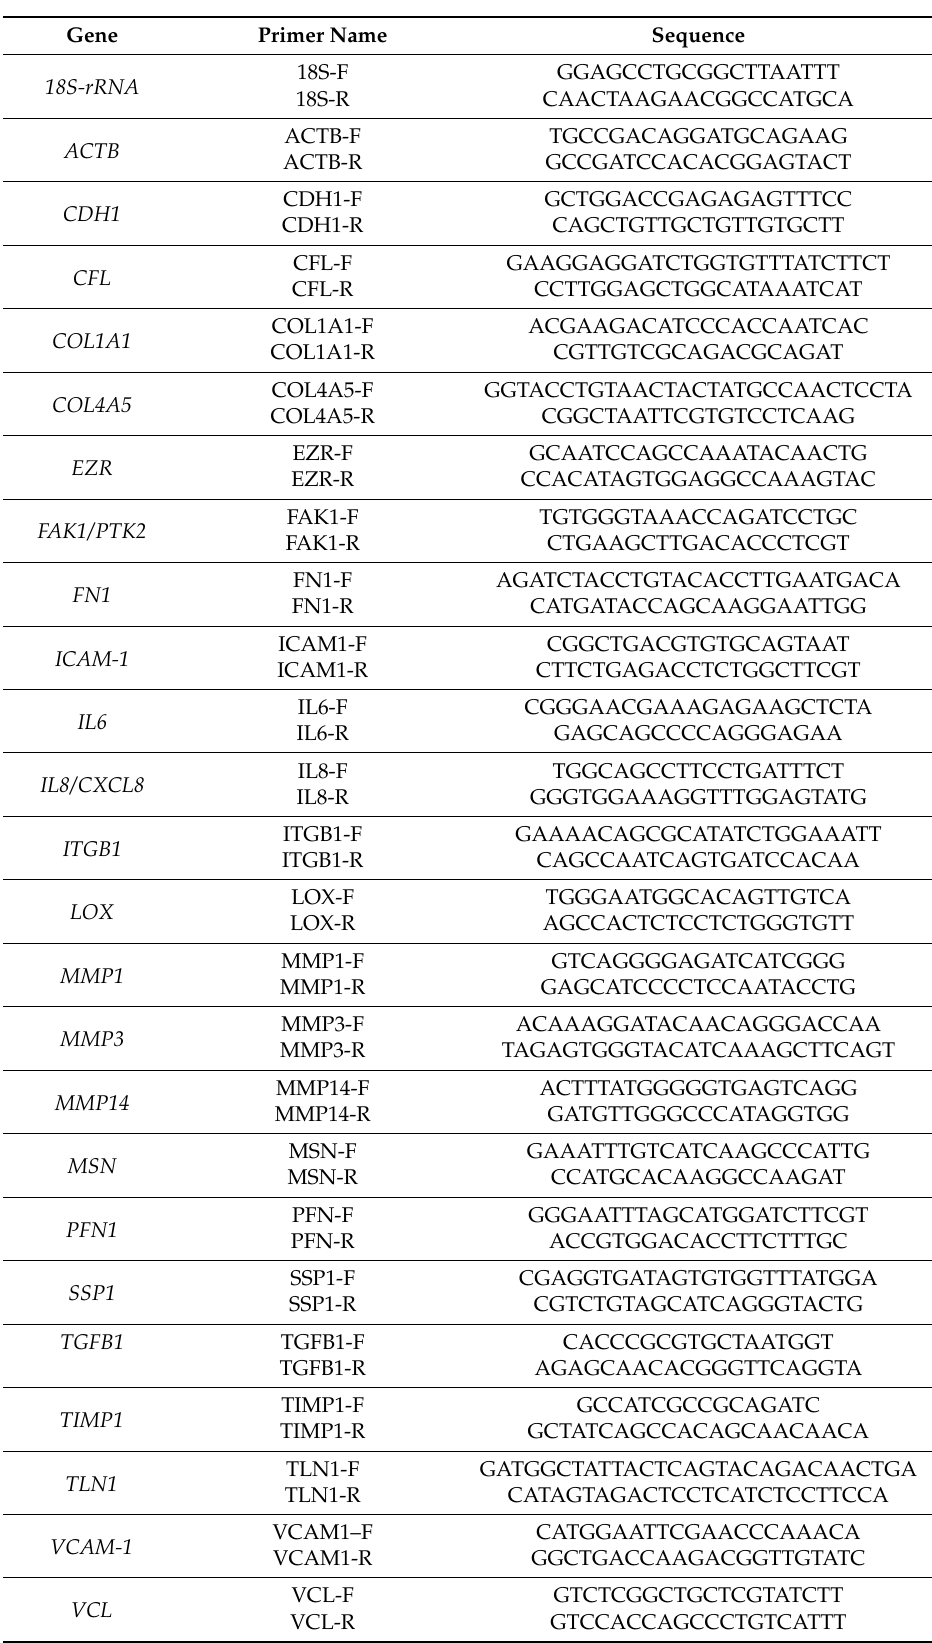
Table 3. Primer sequences for